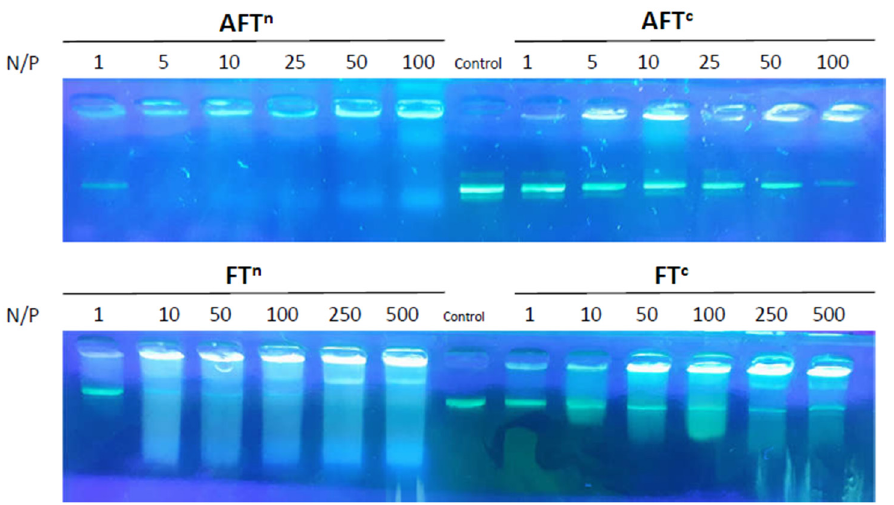
Figure 5. Electrophoresis analysis of pDNA complexation at N/P = 1–500 by the DCPs AFT n and AFT c (top) compared to the fluorophores FT n and FT c (bottom). Control refers to pDNA alone. AFT c ( top ) compared to the fluorophores FT n and FT c ( bottom ). Control refers to pDNA